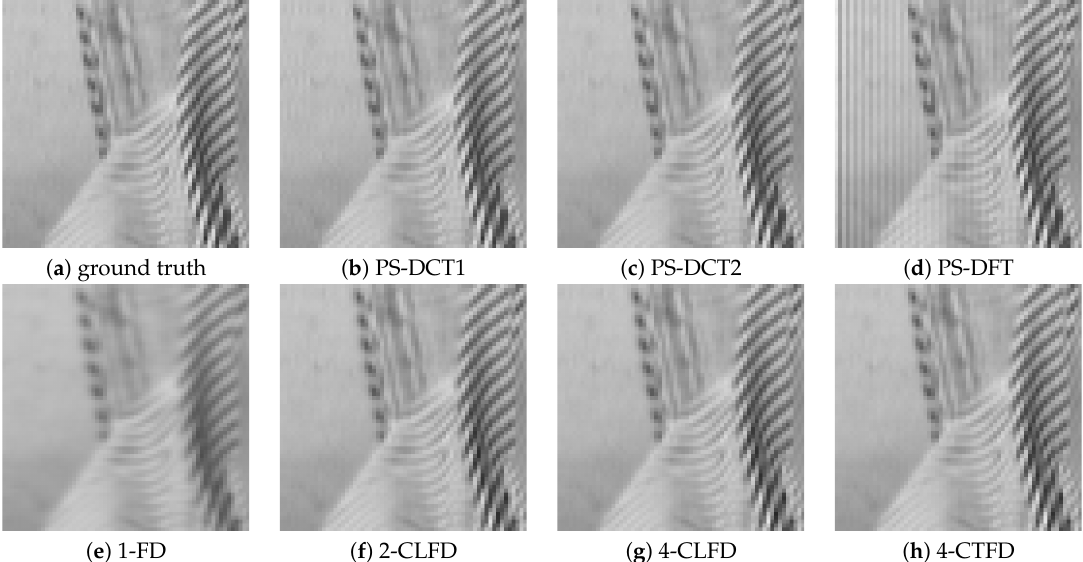
Figure 2. A portion on the leftmost side of the final output after successive image translation of the image “Barbara”. PS, pseudo-spectral; FD, forward difference; CLFD, central finite difference; CTFD, compact finite difference. Table 1. SNRs (dB) of the final output after successive image translation.